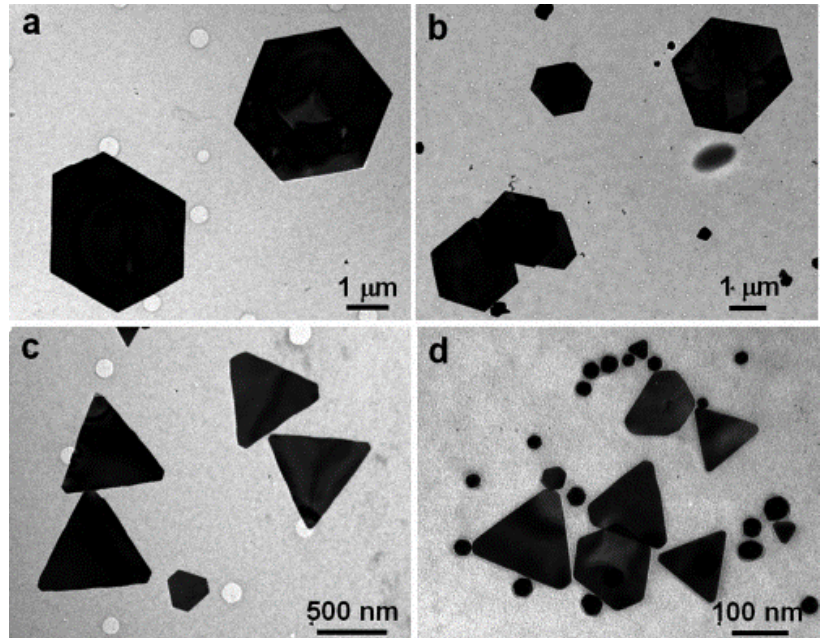
Figure 2. Representative TEM images of gold nanoparticles synthesized by the reduction of 5 mL of an aqueous solution of HAuCl 4 at 10 −3 M with ( a ) 0.2, ( b ) 0.3, ( c ) 0.5, and ( d ) 1.0 mL of lemon grass of an aqueous solution of HAuCl 4 at 10 − 3 M with ( a ) 0.2, ( b ) 0.3, ( c ) 0.5, and ( d ) 1.0 mL of lemon aqueous extract. Scale bars clockwise from top left are 1 µm, 1 µm, 500 nm and 100 nm. Reproduced grass aqueous extract. Scale bars clockwise from top left are 1 µ m, 1 µ m, 500 nm and 100 nm. from Reference [42]. Copyright (2005) American Chemical Society. Reproduced from Reference [42]. Copyright (2005) American Chemical